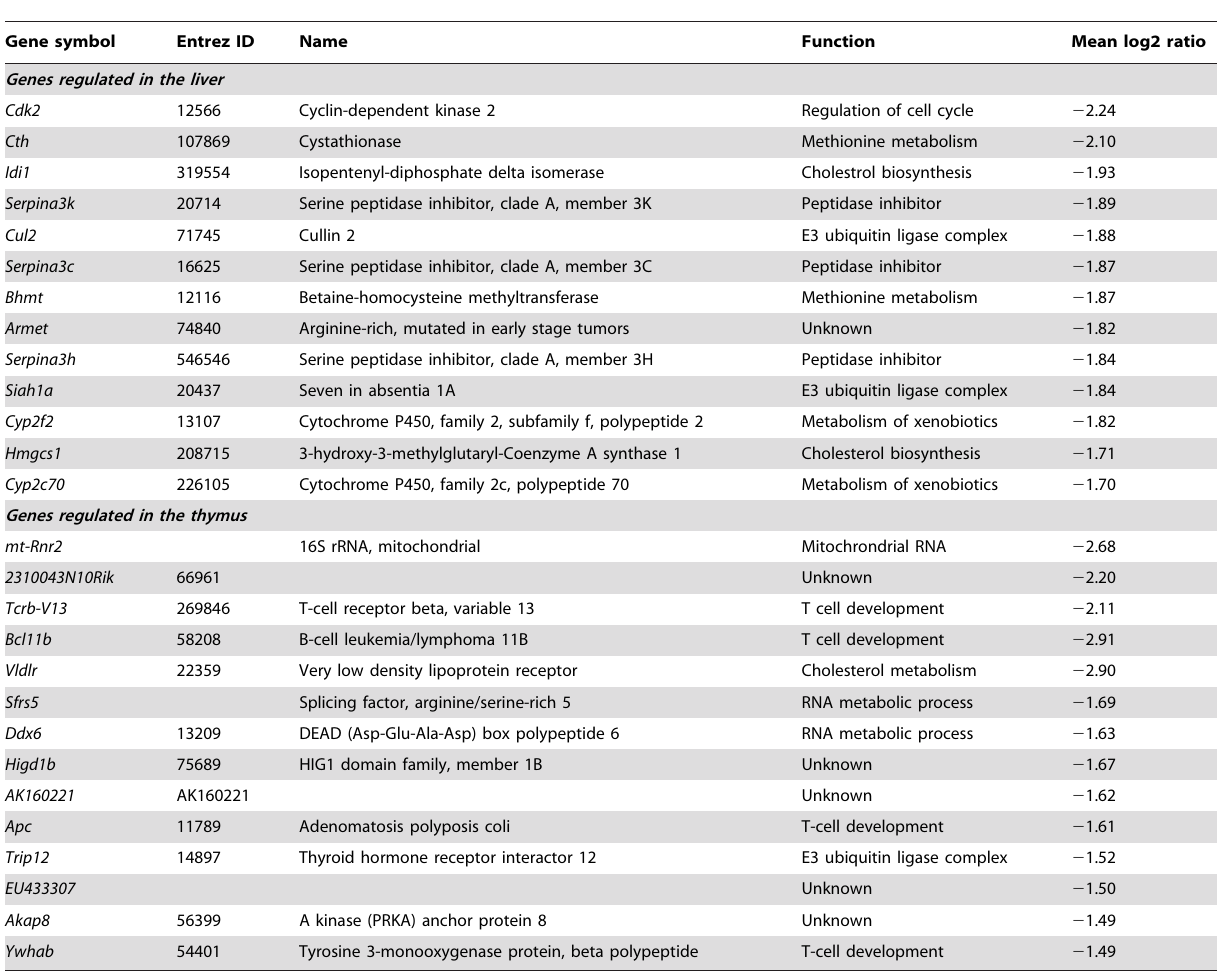
Table 3. Genes regulated in heterozygous C3.Dll1 tm1Gos/ + animals when compared to wild-type littermates.